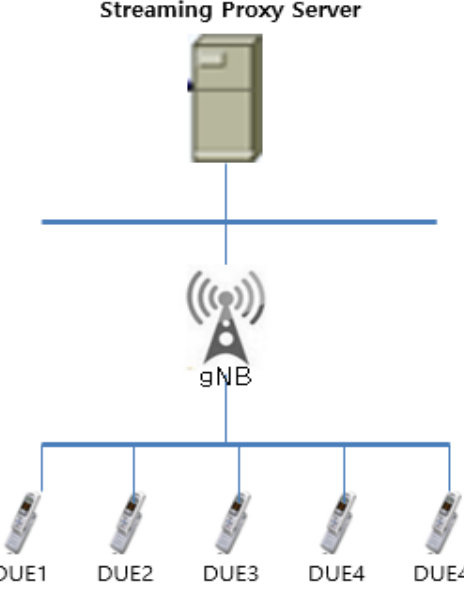
Figure 3. 5G-based D2D streaming network model.